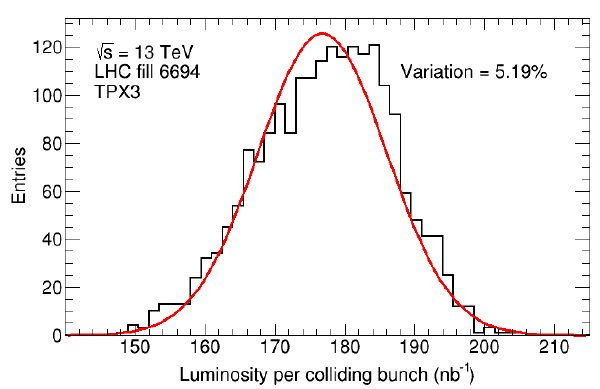
Figure 74. Variation in measured LHC luminosity per colliding bunch. The variation is defined as width over mean of the Gaussian fit to the data. The luminosity is averaged from the measurements of TPX3 layers 1 and 2. The observed variation (asymmetry) is due to the convolution of the TPX3 measurement precision and the differences in the (non-Gaussian) intensities of the individual LHC bunches. The data are integrated over LHC fill 6694. Taken from Ref.